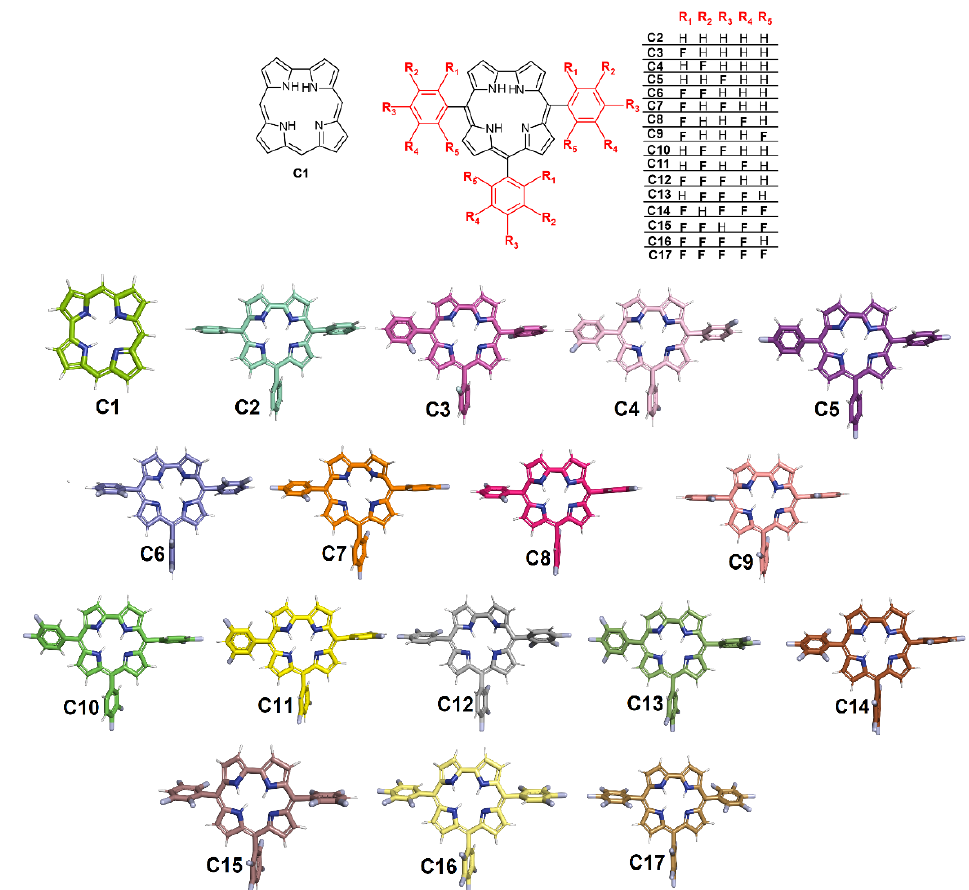
Figure 1. The chemical structures of corrole C1 , meso -aryl-corrole ( C2 ), and fluorinated- meso -aryl- corrole derivatives ( C3 – C17 ). The color used to represent the 3D structures of the corroles corre- sponding to the same used in the docking representations.